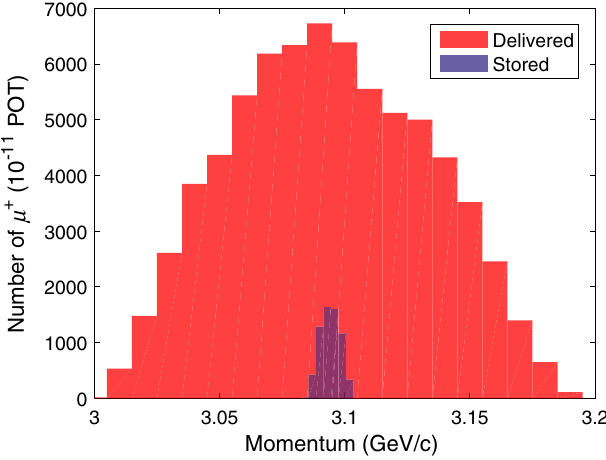
FIG. 1. Momentum distribution of the Muon Campus beam at the entrance of the storage ring (red). Momentum distribution of the same beam but after completing 100 turns inside the ring (blue). Notice that the rms momentum spread of the surviving beam is 0.12% meaning that a big fraction of the incoming beam is lost. POT refers to the protons on